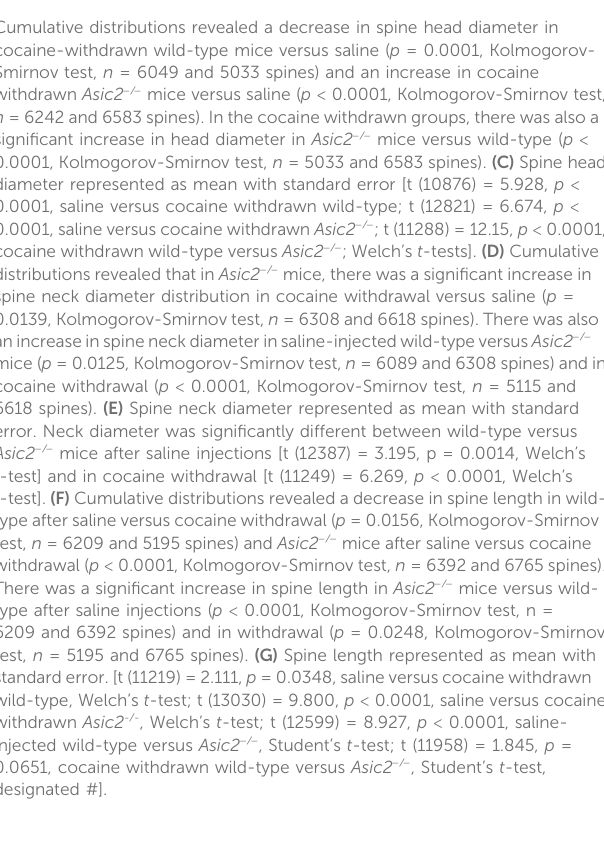
SUPPLEMENTARY FIGURE S2 ASIC2 disruption and cocaine withdrawal had effects on individual spine morphology measurements. (A) Schematic showing each spine morphology measurement, head diameter, neck diameter and spine length.